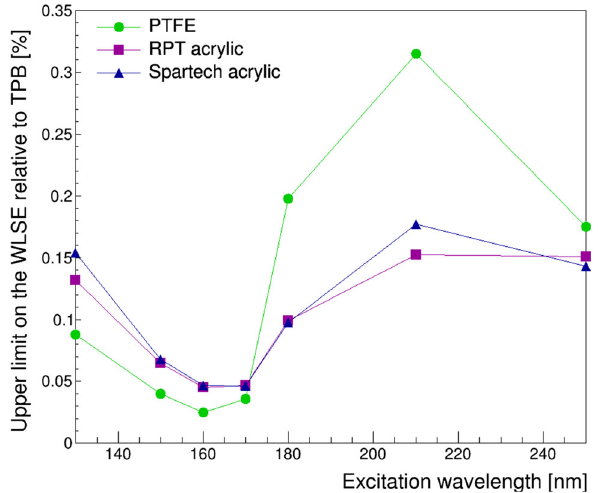
Fig. 7 Upper limit on the wavelength shifting efficiency of PTFE (cir- cle) , RPT acrylic (square), and Spartech acrylic (triangle) relative to TPBfordifferent excitationwavelengths.Linesareshown onlytoguide the